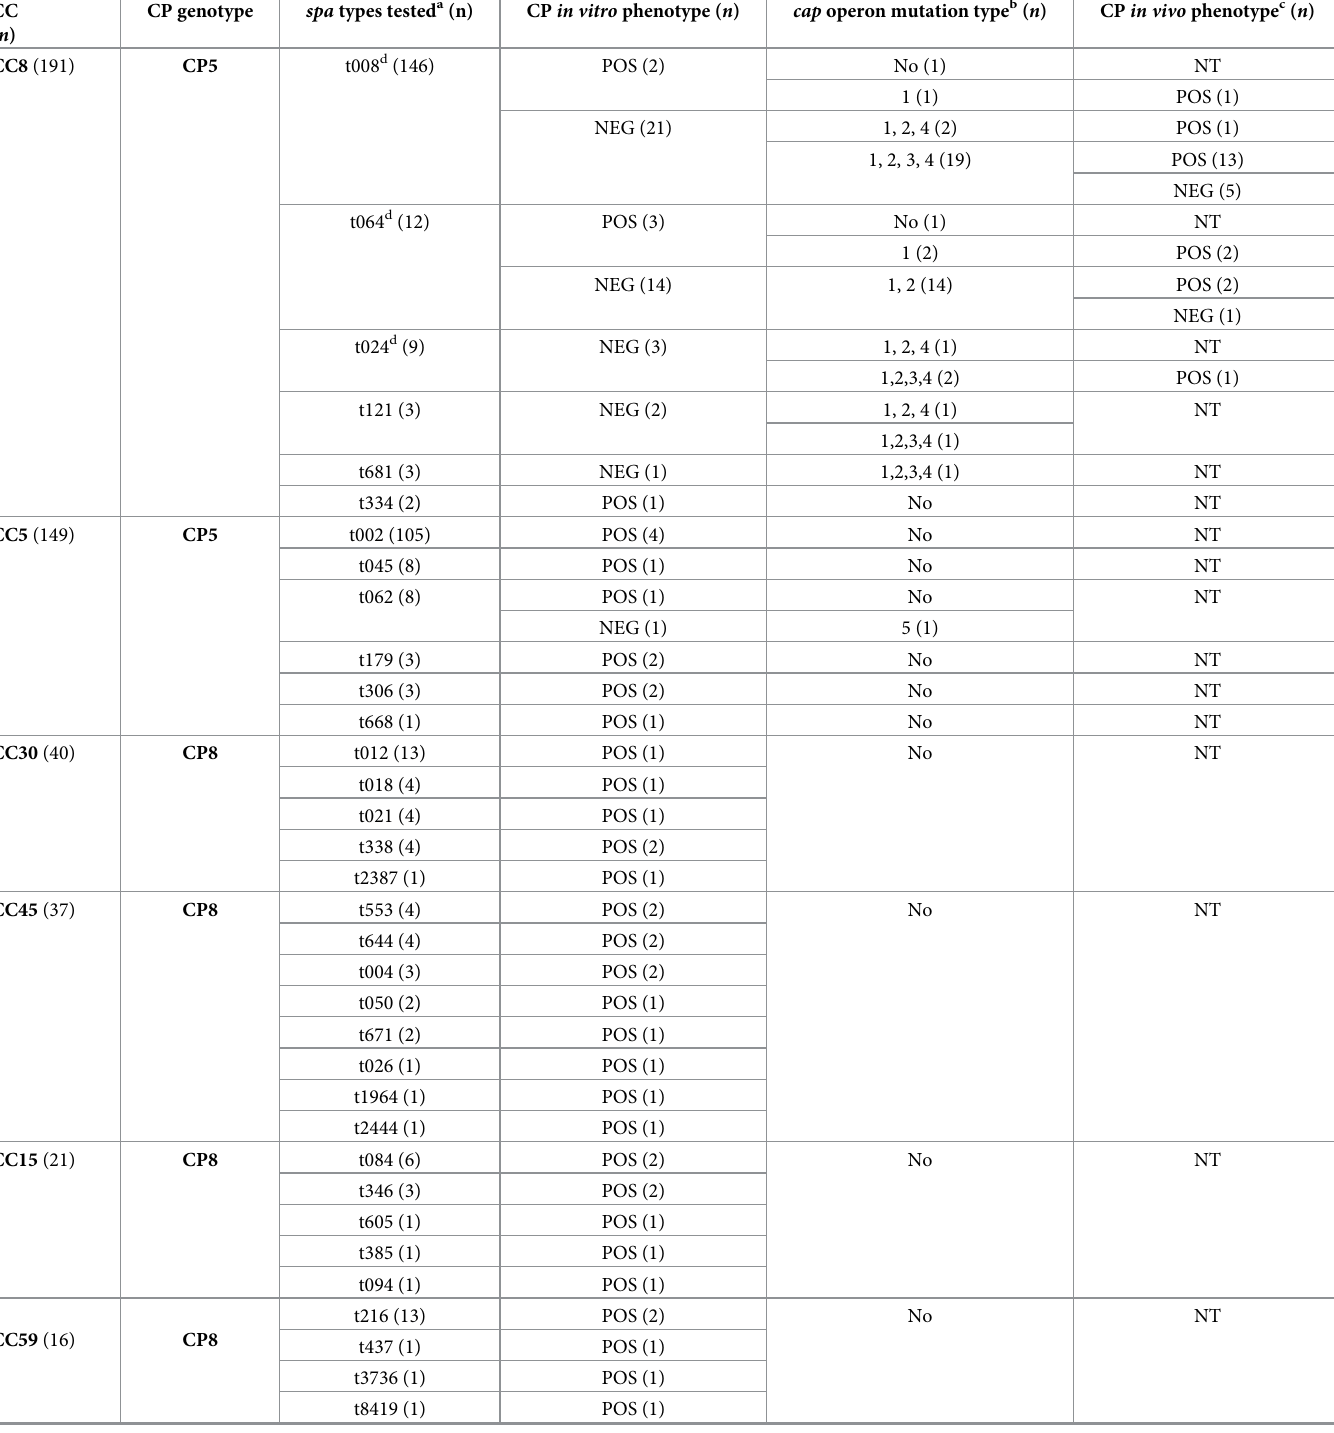
Table 2. In vitro and in vivo capsule expression by S . aureus isolates from major disease-causing clonal complexes (CC) and associated prevalent spa